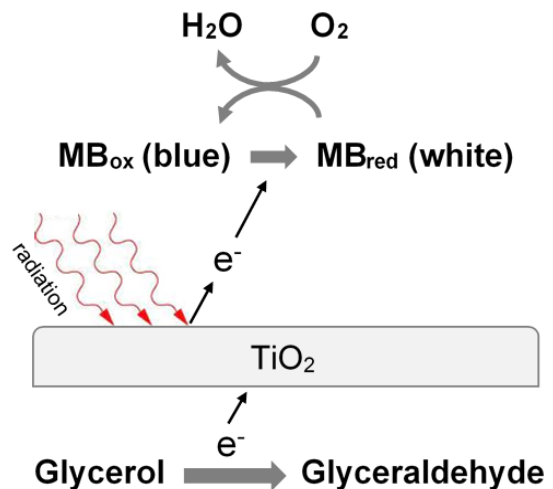
Figure 16. Mechanism scheme of the sensor for O 2 detection. (Adapted with permission from [39], open access Creative Common CC licenced 4.0, MDPI).